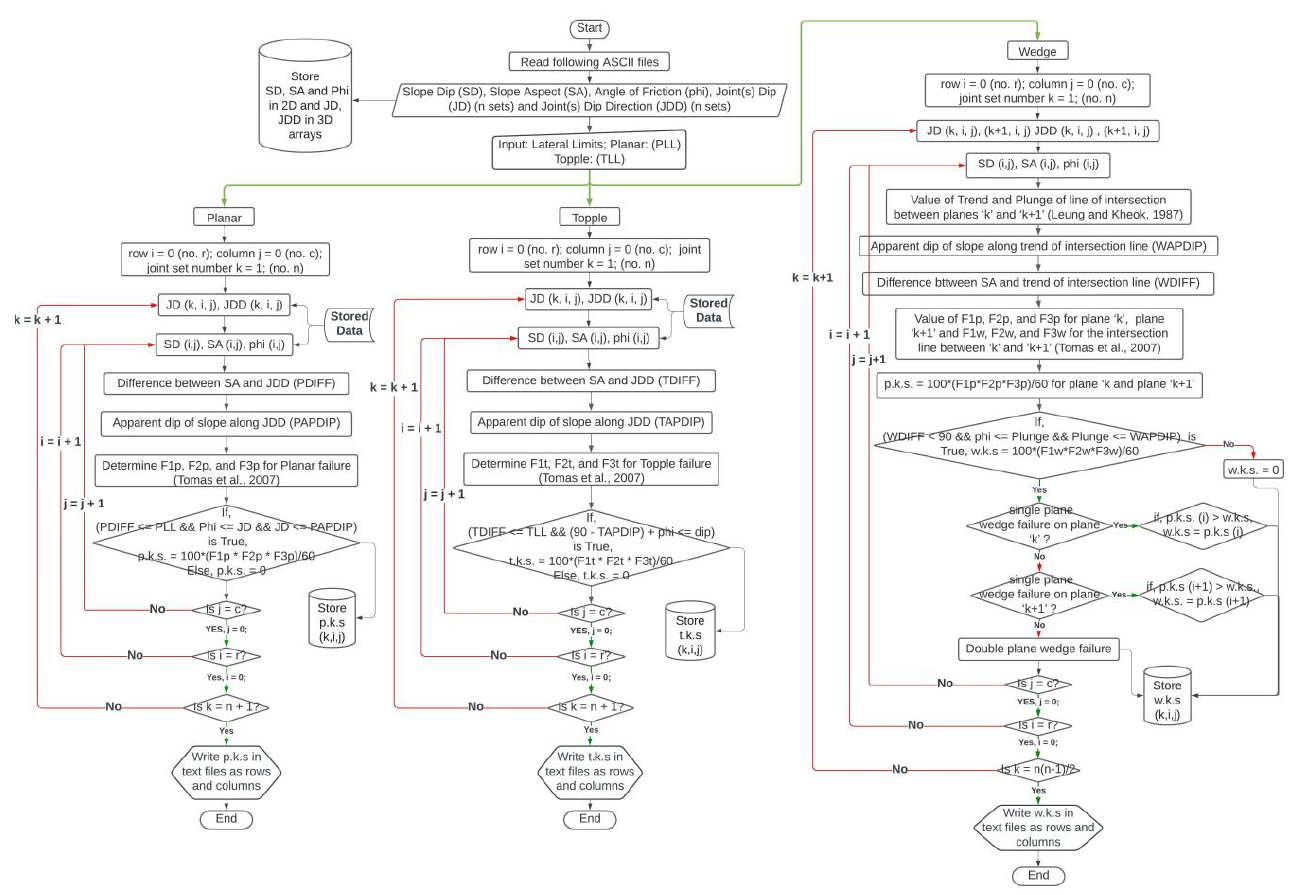
Figure 4. Flowchart of GISMR for kinematic analysis describing the calculation process for planar, topple, and wedge failure.